Question: Compose a caption that would accompany this figure in a paper.
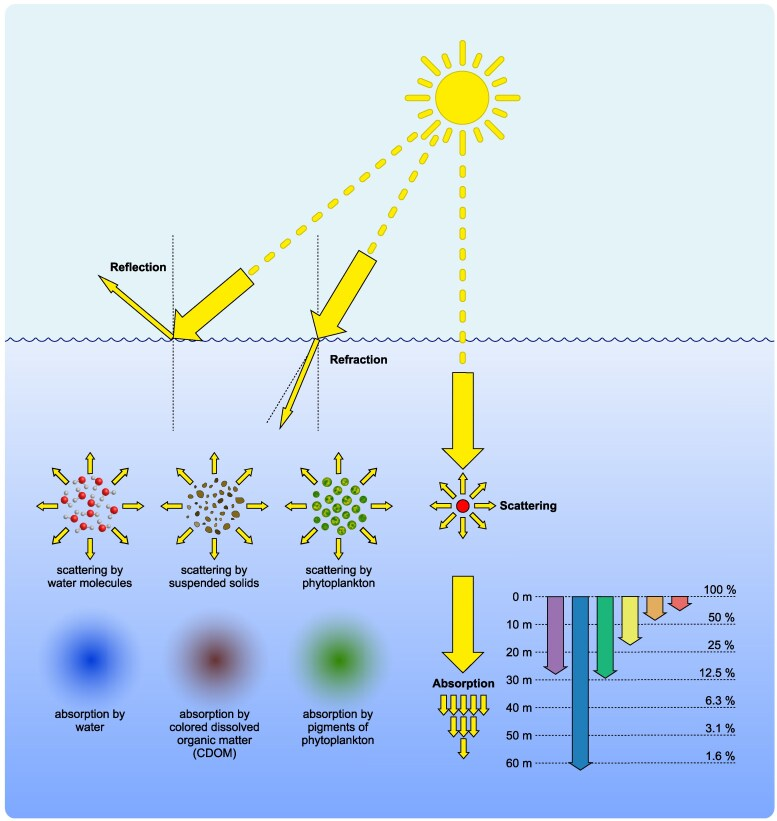
Answer: Optical processes shaping the underwater light field. Incident solar radiation is partially reflected at the air–water interface, while the refracted component enters the water column where it is progressively modified by wavelength-dependent scattering (Rayleigh and Mie processes) and absorption by pure water, CDOM, and algal pigments. These combined processes determine the vertical decline of light intensity and spectral diversity in natural waters and establish depth-dependent optical niches for photosynthesis and photoreception. Conceptual illustration synthesized from information presented in Mobley (1994) ; Falkowski and Raven (2007) ; Kirk (2010) ; Contreras-Silva et al. (2012) ; Larkum et al. (2018) ; Kim and Lee (2022) ; Huang et al. (2024) ; Xu et al. (2025a) .